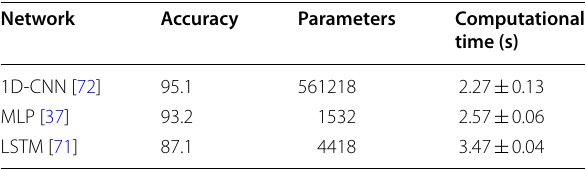
Table 3 Performance comparison, extracted from [72]